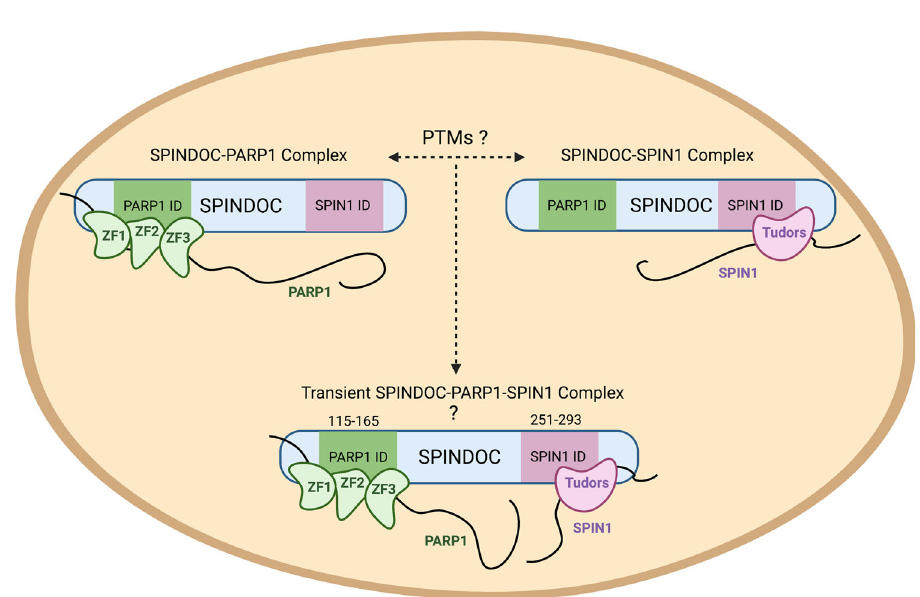
Fig. 8 SPINDOC forms two stable protein complexes. SPINDOC harbors a PARP1-interacting domain (ID) and a SPIN1 ID. Even though the two interacting domains are separated by ~100 amino acids, a stable complex of all three proteins is not observed, suggesting that the binding of PARP1 to SPINDOC sterically interferes with the SPIN1 interaction, and vice versa. It is unclear what regulates the inclusion of SPINDOC into the two different complexes, but the distribution is likely regulated by post-translational modi fi cations (PTMs). Although we see no evidence of SPINDOC interacting with both its binding partners at the same time, it might be possible that a transient trimeric complex can form on rare occasions, which could possibly facilitate the recruitment of PARP1 to SPIN1 transcriptional targets. The model was created with